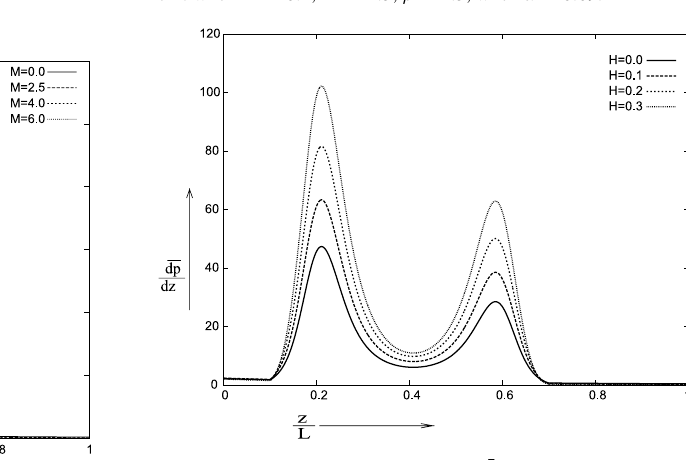
¯ dp z fordifferentvalues dz )with